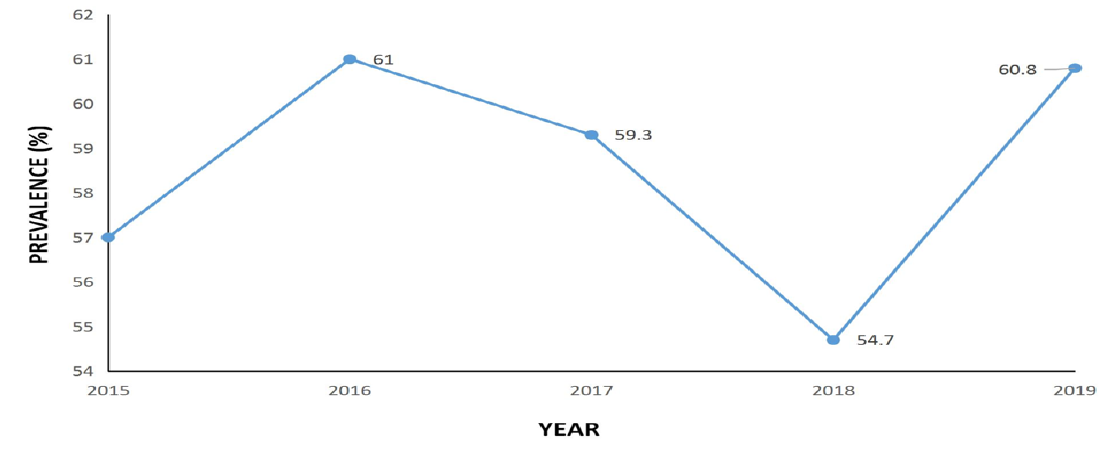
Figure 2. Sero-prevalence trend of H. pylori infection during the 5-year period.